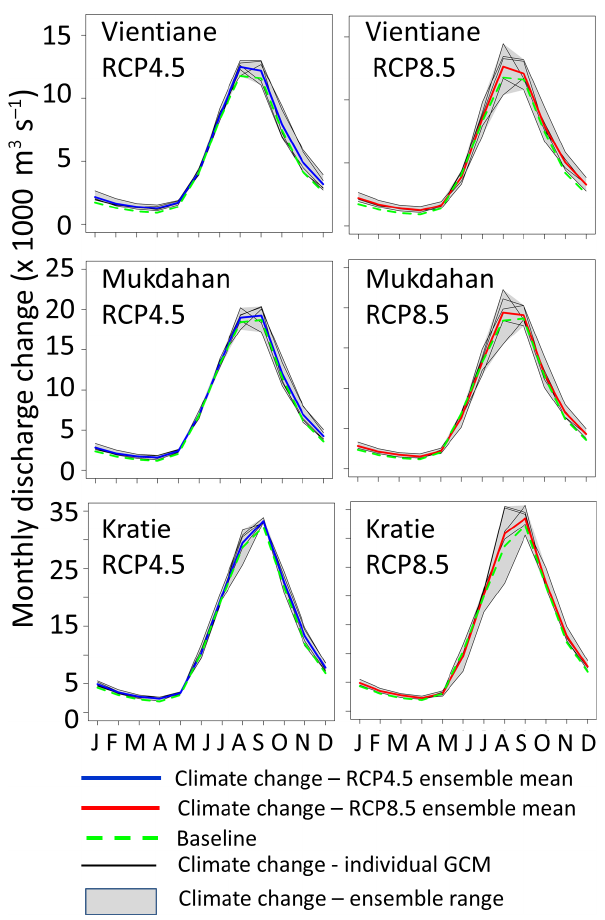
Figure 5. Projected monthly river discharge under climate